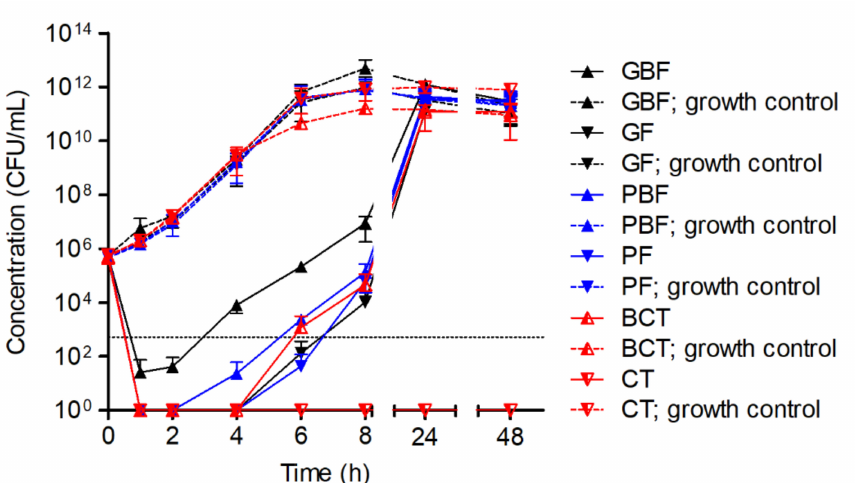
Figure 4. Time–kill curves of the 16-fold MIC of HY-133 against S. aureus strain ATCC 29213 incubated in different culture vessel types shaking at 160 rpm. Plot shows mean values for log 10 of the numbers of CFU/mL versus time. The threshold (dotted line) implicates the ≥ 3 − log 10 decrease in CFU/mL. Time–kill curves were performed in triplicate (mean ± standard deviation). A culture of S. aureus strain ATCC 29213 without HY-133 was always included as a growth control (dashed lines) for each vessel type. GBF, glass baffled flask; GF, glass flask; PBF, plastic baffled flask; PF, plastic flask; BCT, baffled centrifuge tubes; CT, centrifuge tube.